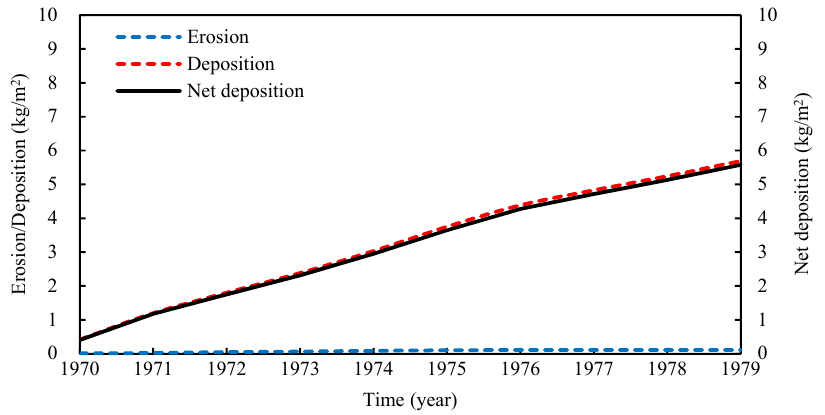
Figure 10. The average erosion (blue dashed line), deposition (red dashed line) and net deposition (solid black line) per unit area for the QL system from 1970 to 1979.